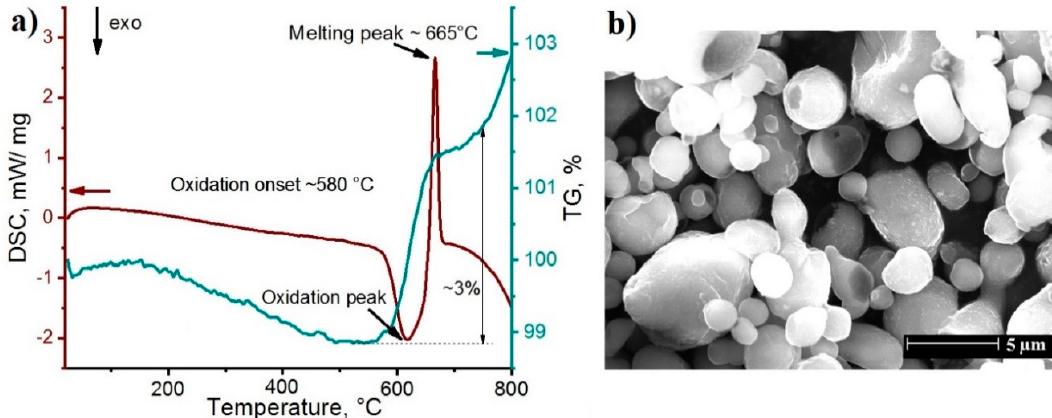
Figure 2. Thermogravimetry (TG) and differential scanning calorimetry (DSC) curves of the powder ( a ) and SEM image of the powder after TG and DSC measurements ( b ).